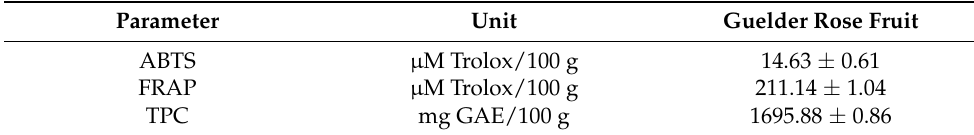
Table 2. The values of ABTS, FRAP and TPC in guelder rose fruit. Parameter Unit Guelder Rose Fruit ABTS